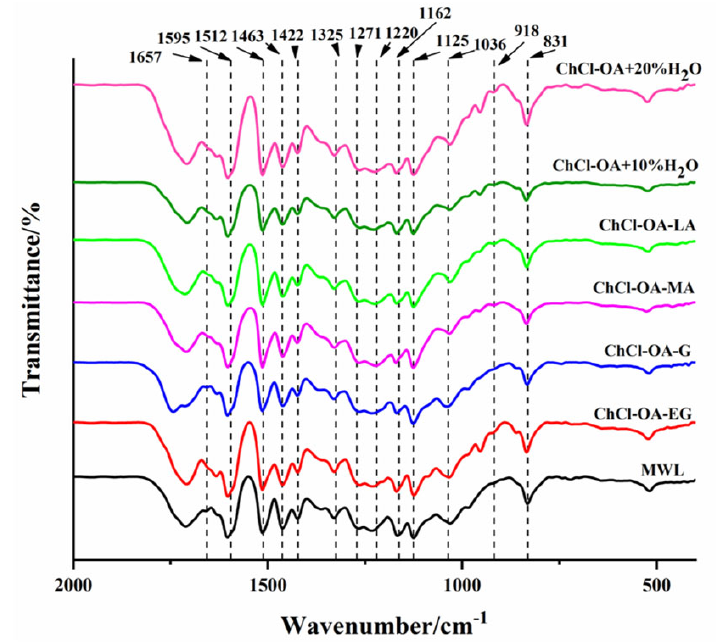
Figure 4. FTIR spectra of the Lignin was extracted after DES treatment (DES − L) prepared with different DESs.